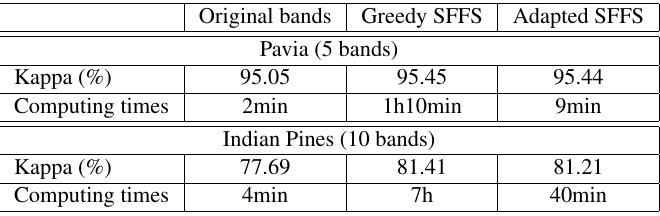
Figure 7: Computing times and best Kappa coefficients reached on Pavia (for a 5 band subset) and Indian Pines (for a 10 band subset) data sets for band merging criterion “spectra piece-wise approximation error” to the greedy approach, this new algorithm uses the band subset selected at the previous lower level when performing band selec- tion at a new level of the hierarchy of merged bands.